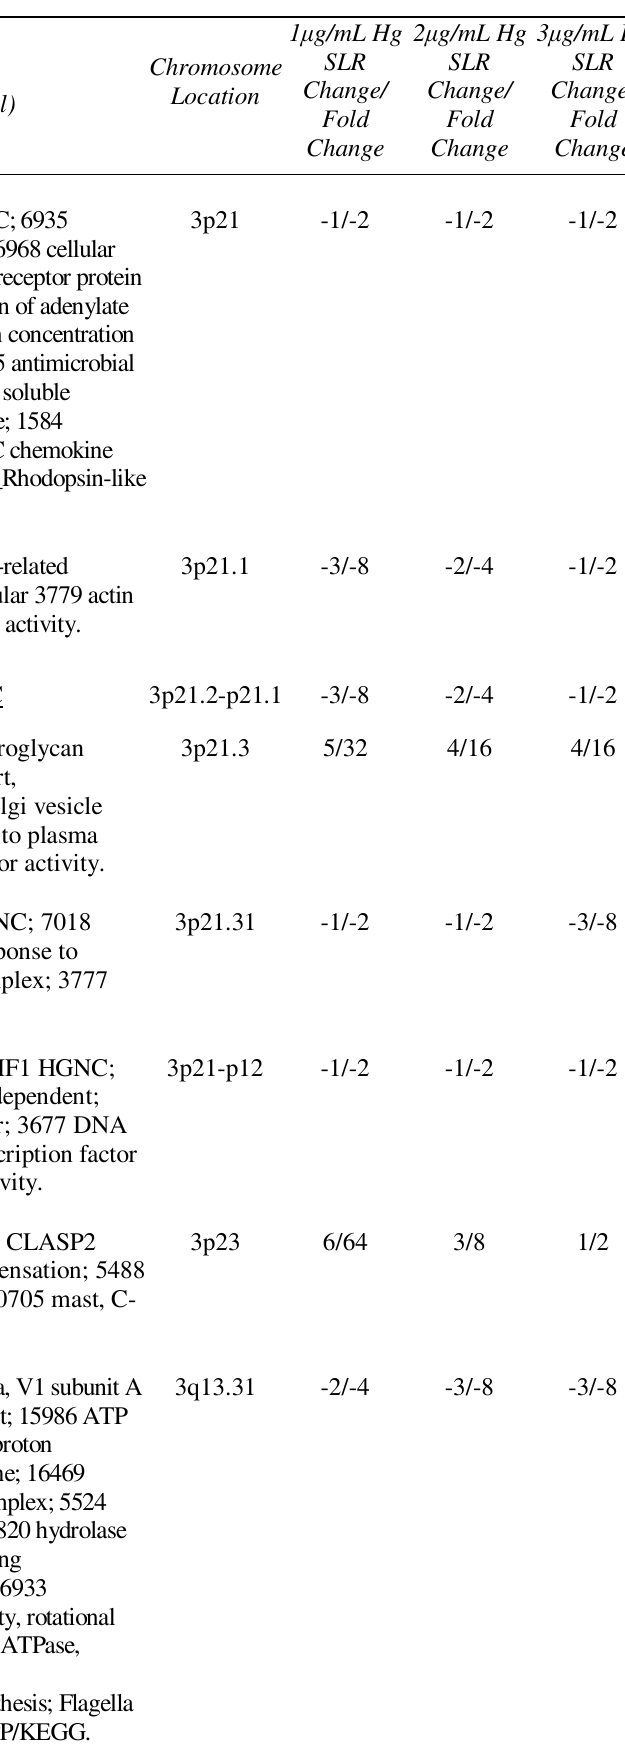
SLR-- signal log ratios